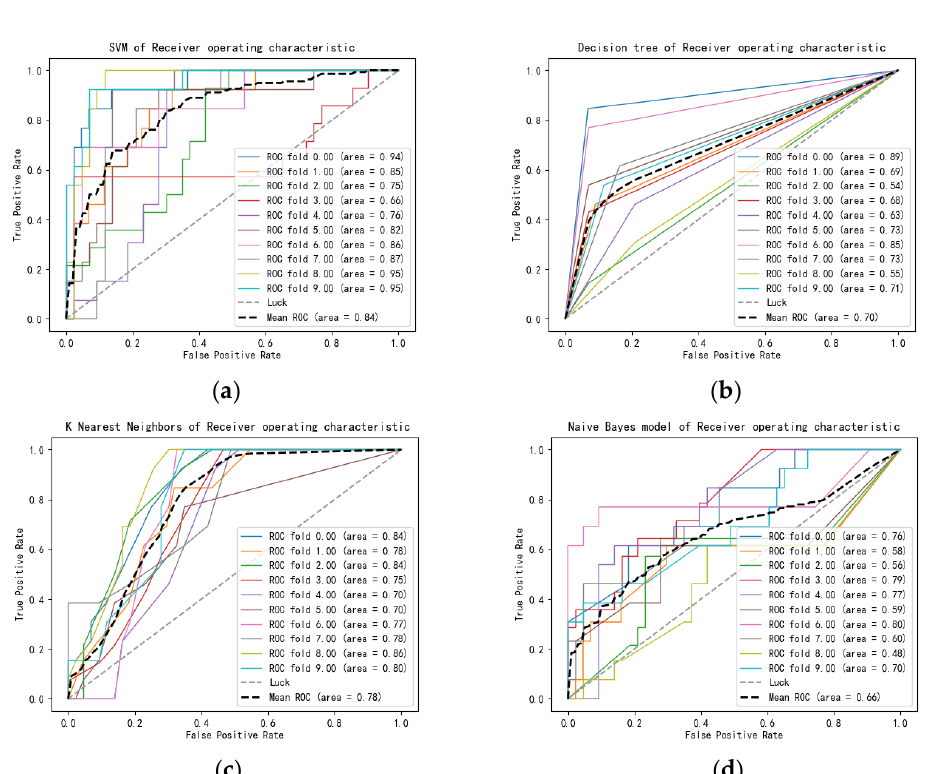
Figure 16. ( a ) SVM of Receiver operating characteristic; ( b ) Decision tree of Receiver operating characteristic; ( c ) K Nearest Neighbors of Receiver operating characteristic; ( d ) Naive Bayes model of Receiver characteristic.